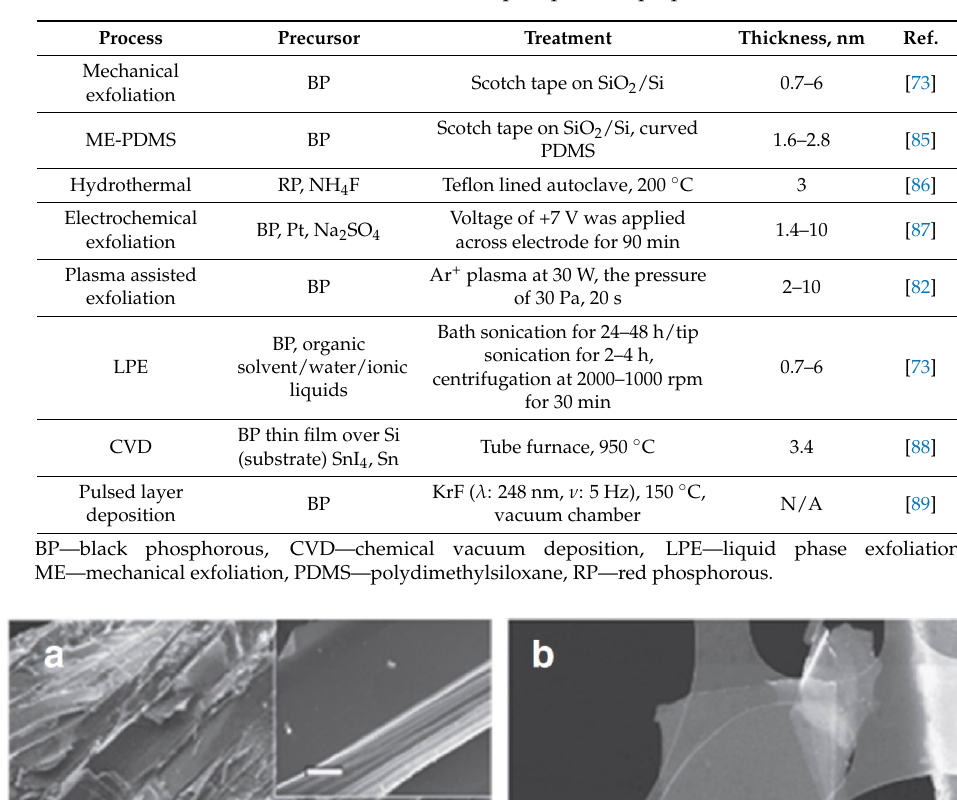
Table 2. Methods used for phosphorene preparation.